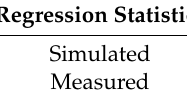
Table 4. Regression statistical analysis results of the total simulated value and the measured value of